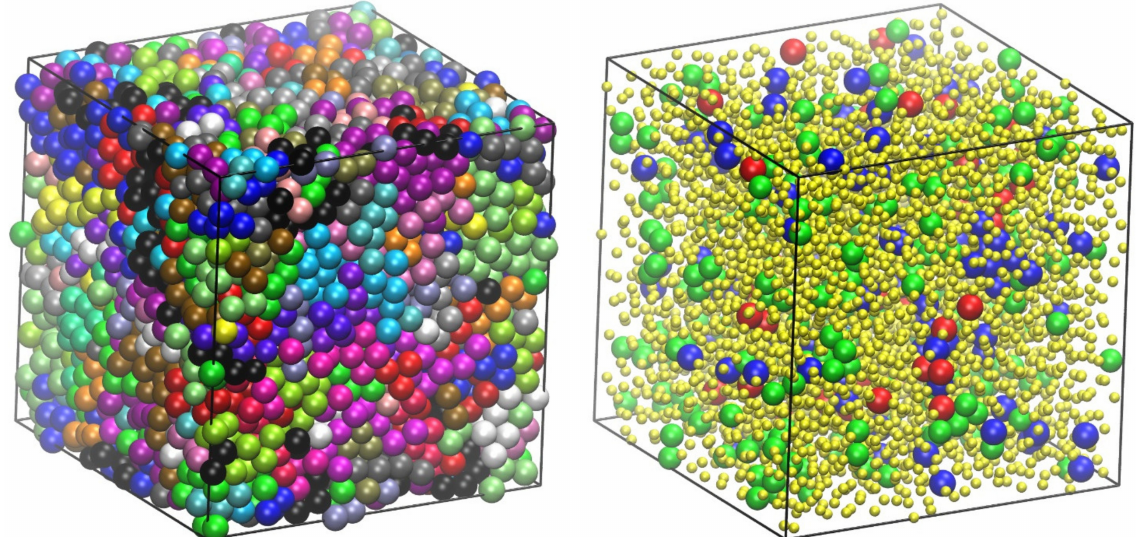
Figure 6. Jammed packing of semi-flexible chains of tangent hard spheres of uniform size with average length of N = 100 and an equilibrium angle of θ 0 = 120 ◦ at a packing density of ϕ = 0.637. ( Left panel ): Monomers are colored according to the parent chain; ( Right panel ): Monomers are colored according to the lowest value of the CCE norm. Blue, red, and green denote HCP, FCC, and FIV similarity, respectively. Amorphous (AMO) ones are colored yellow with reduced dimensions for clarity. Sphere monomers are shown with coordinates of their centers being subjected to periodic boundary conditions. Image created with the VMD visualization software [54]. Figure panels are also available as interactive, 3-D images in Supplementary